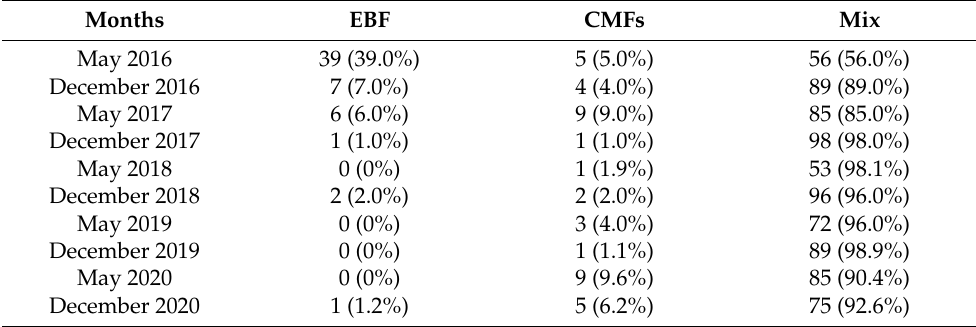
Table 3. Trend of feeding according to type of